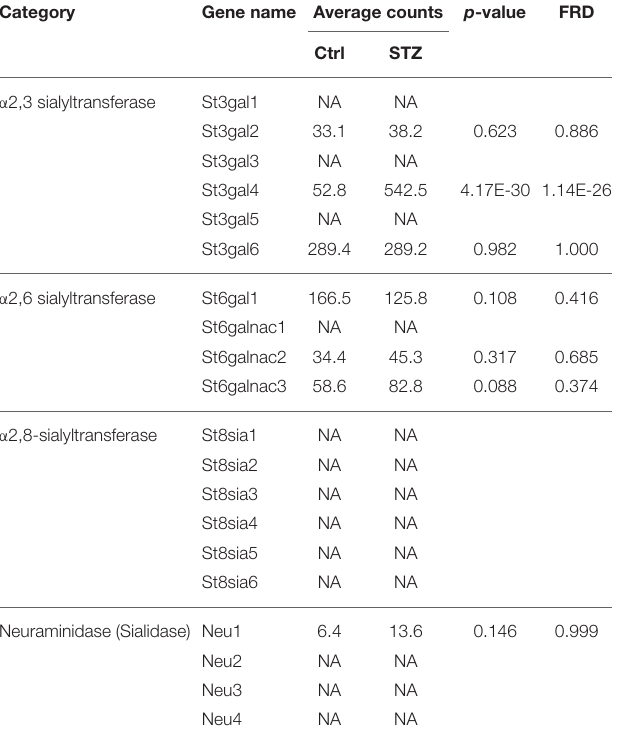
TABLE 3 | Summary of sialyltransferase and neuraminidase genes from kidney IM. Category